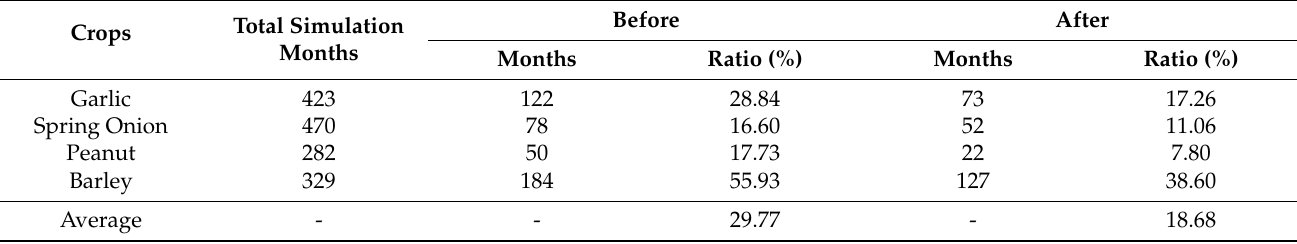
Table 7. Comparison of agricultural water deficit durations (months) before and after introducing the mool-tongs.